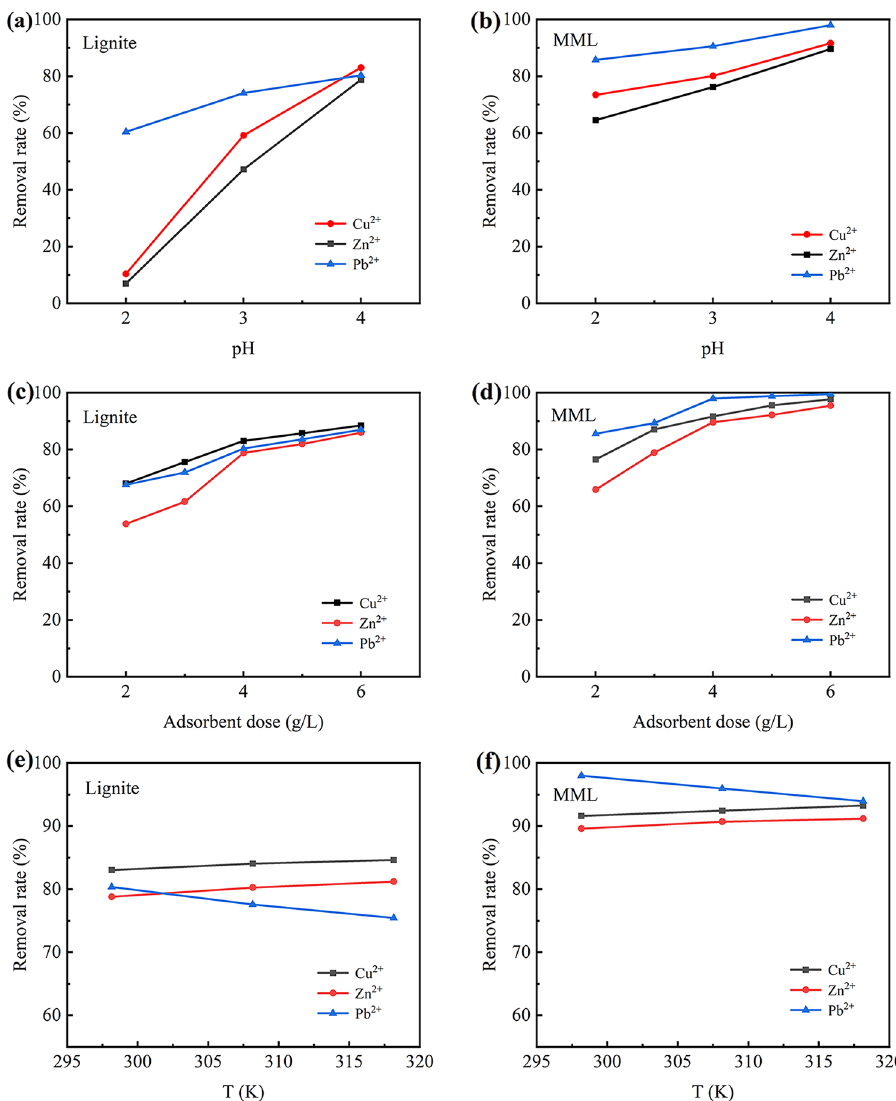
Figure 1. Relationship between the pH value and adsorption effect: ( a ) lignite; ( b ) MML. Relationship between adsorbent dose and adsorption effect: ( c ) lignite; ( d ) MML. Relationship between temperature and adsorption effect: ( e ) lignite; ( f )